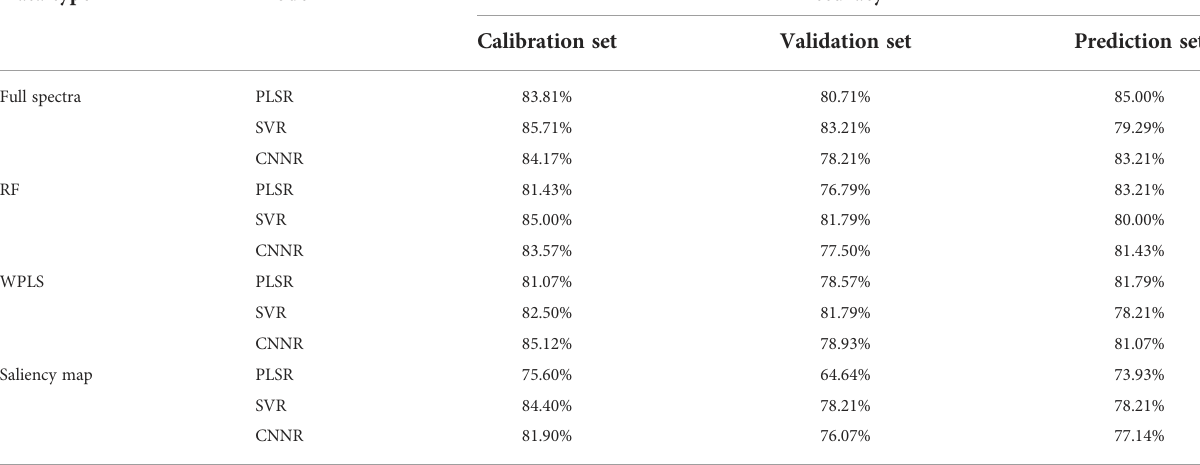
TABLE 7 The identi fi cation results of cotton leaves based on the predicted